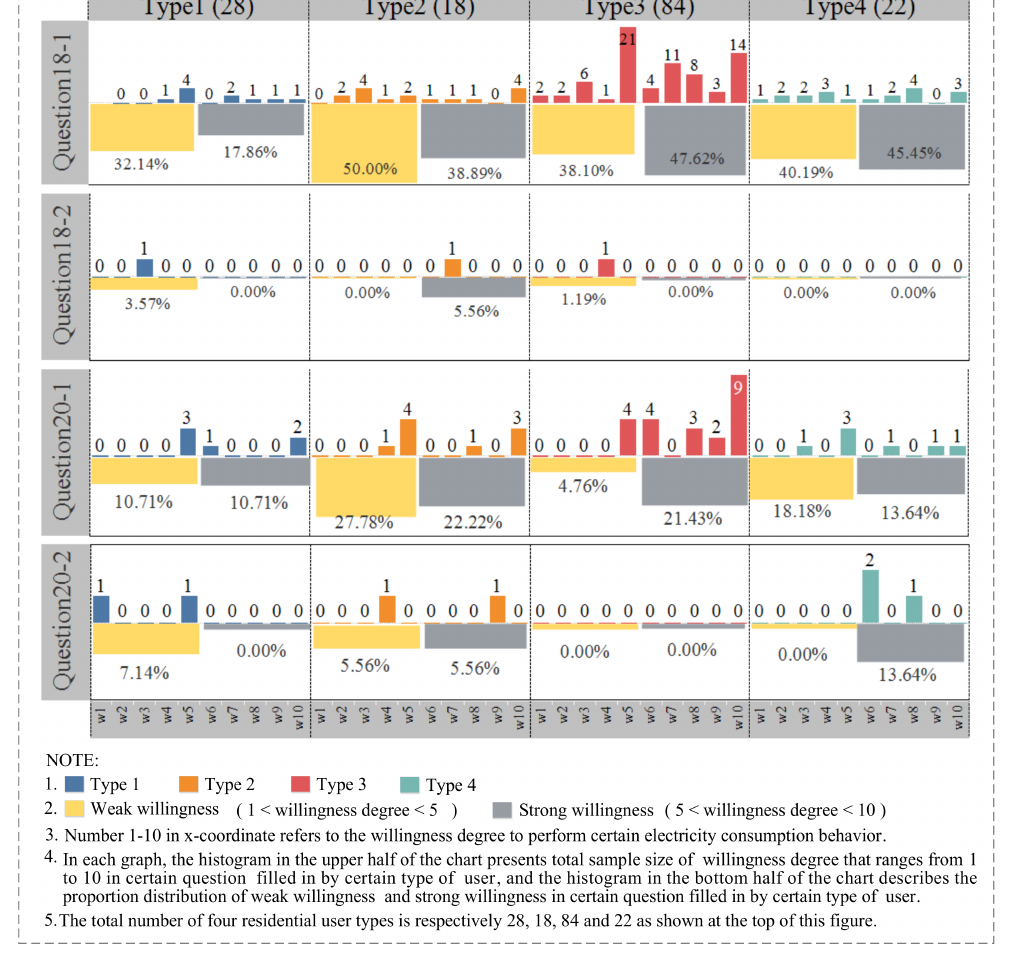
Figure 4. The proportion distribution of weak and strong